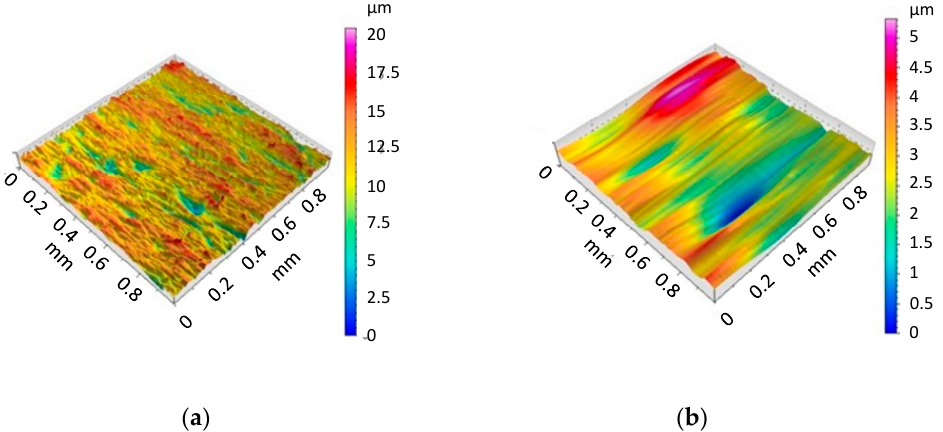
Figure 7. The surface roughness ( a ) and waviness ( b ) of the specimen.